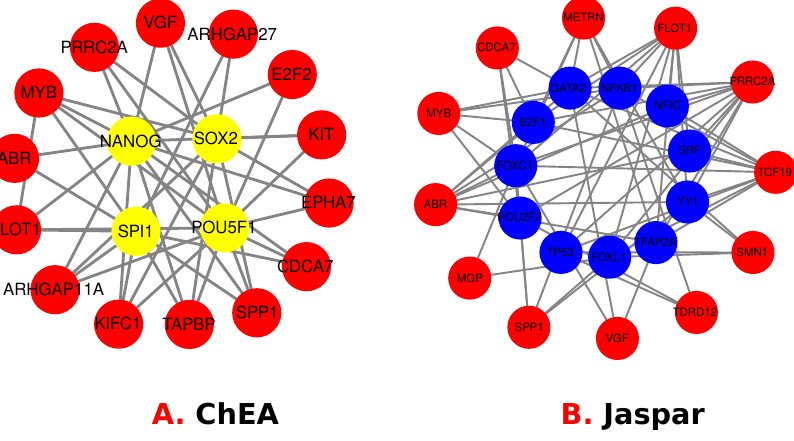
Figure 7. Hub proteins identified using 2 different cyto-hubba algorithms called MCC and BottleNeck to demonstrate the association between T2D and Smoking.